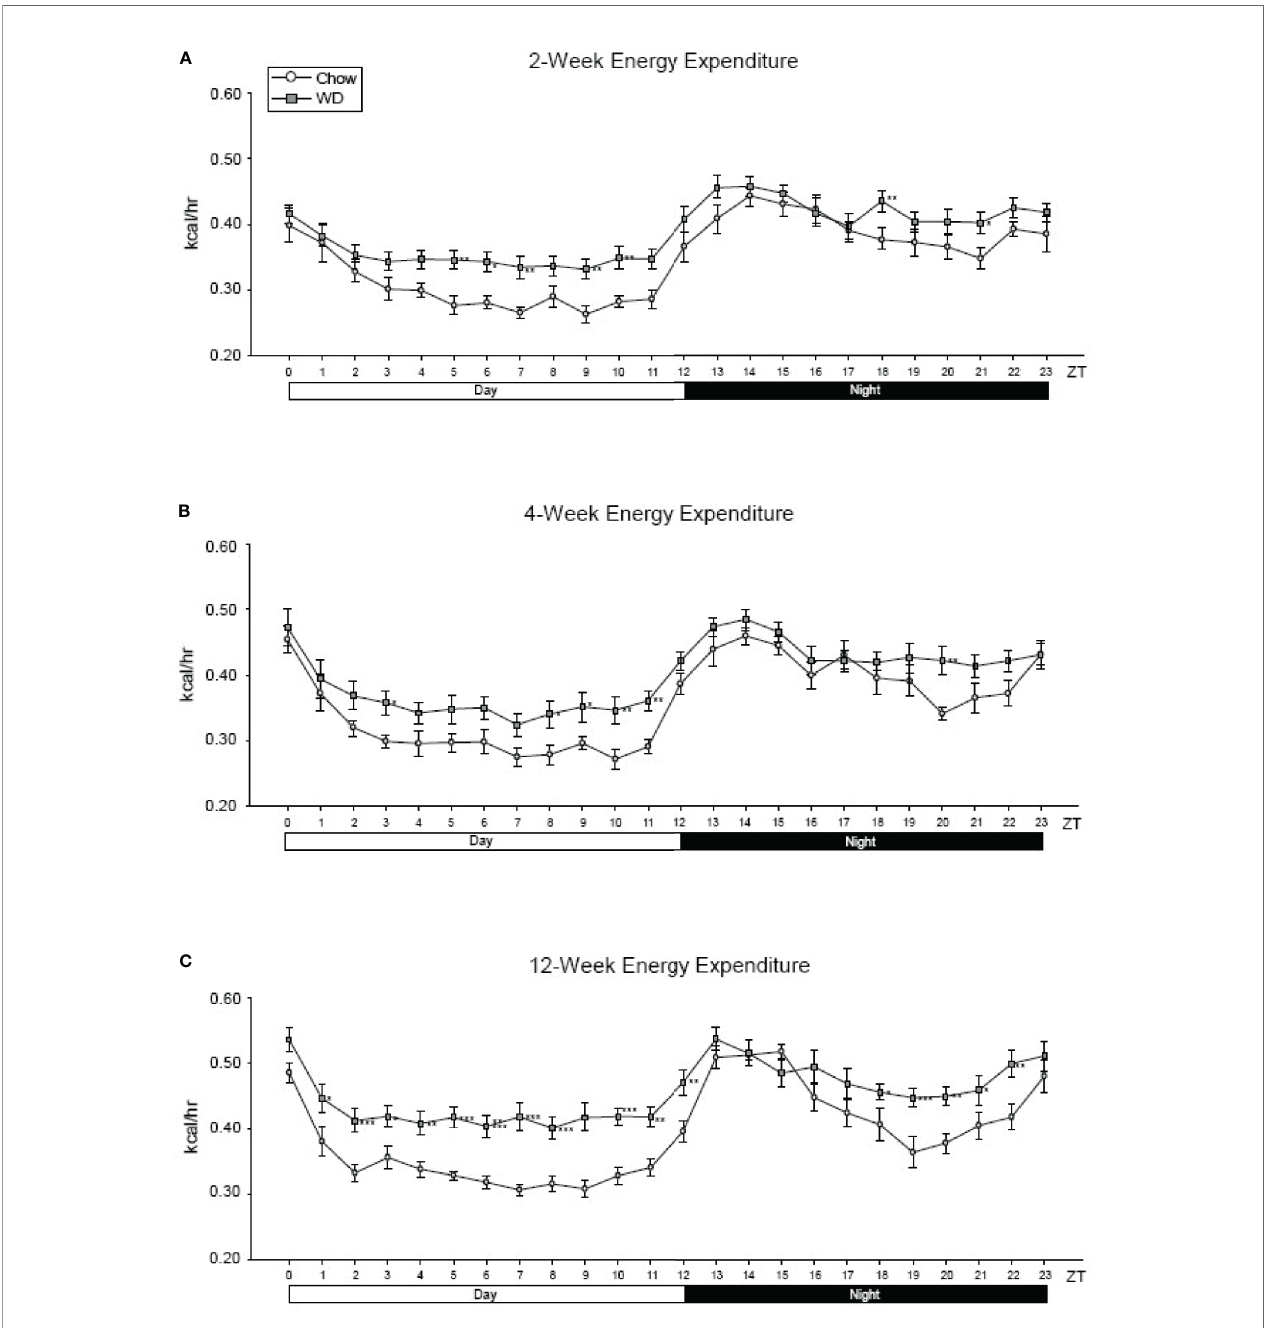
FIGURE 2 | Energy expenditure at 2-, 4- and 12-weeks. (A) Mean circadian analysis of energy expenditure at each hour in the 24-hour cycle in the Chow and WD groups after 2-weeks of dietary exposure. (B) Mean circadian analysis of energy expenditure at each hour in the 24-hour cycle in the Chow and WD groups after 4-weeks of dietary exposure. (C) Mean circadian analysis of energy expenditure at each hour in the 24-hour cycle in the Chow and WD groups after 12-weeks of dietary exposure. All data points are shown as group mean ± SE. (*p < 0.05, **p < 0.01, ***p < 0.001 compared to